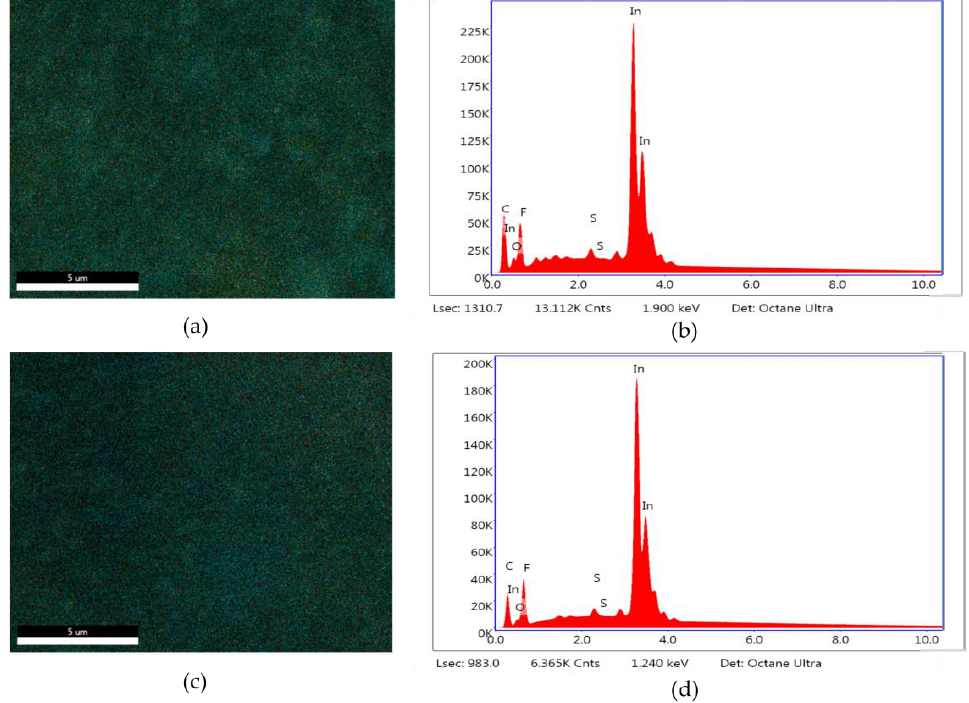
Figure 9. Pre-electrolysis: ( a ) In distribution mapping of the fresh In 50 /C 50 electrode surface; ( b ) EDS measurements of the fresh In 50 /C 50 electrode; post-electrolysis: ( c ) In distribution mapping of In 50 /C 50 electrode surface after CO 2 RR; ( d ) EDS measurements of the In 50 /C 50 electrode after CO 2 RR.